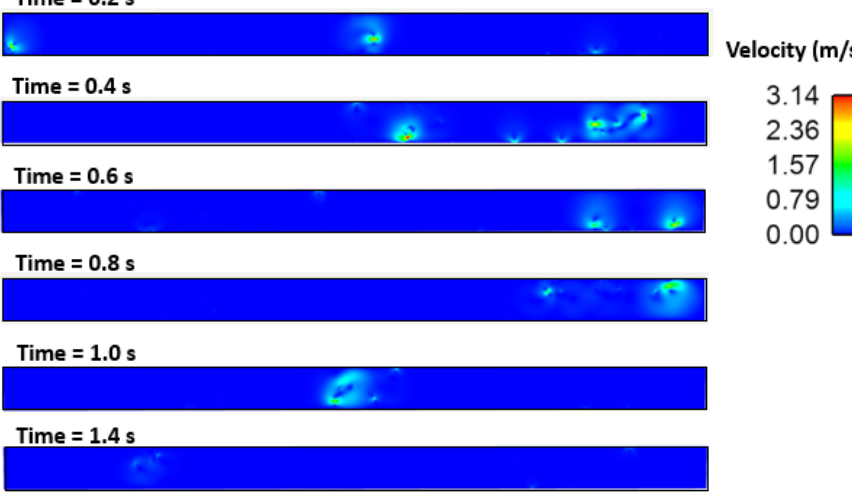
Figure 11. Velocity field of inclusion and molten steel (S: 10 PPM).